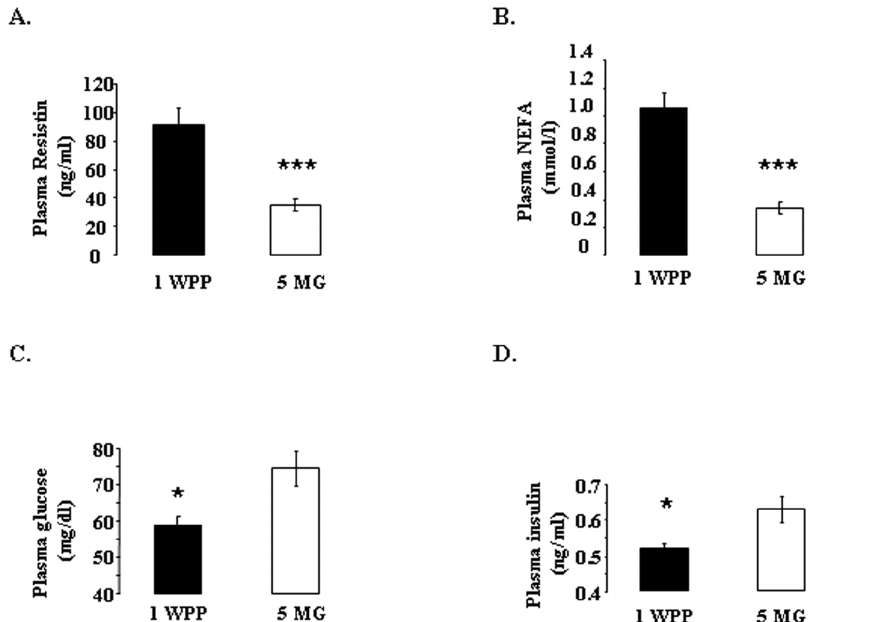
Resistin Milk Yield Dry matter intake Energy Balance Live Body Weight